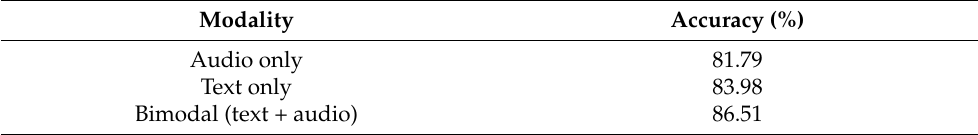
Table 4. The accuracy results of the single and bimodal modality.